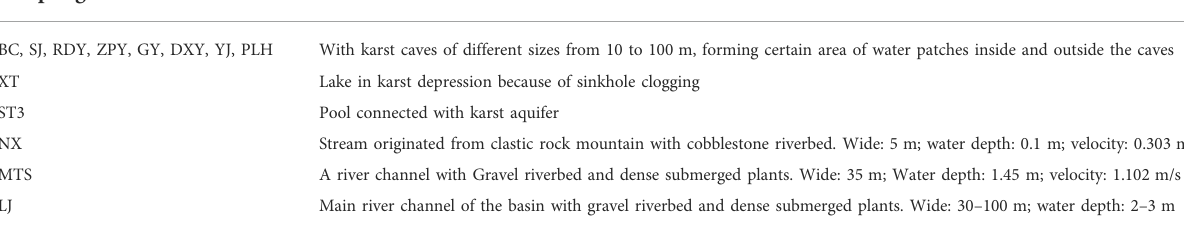
TABLE 1 Information on the sampling